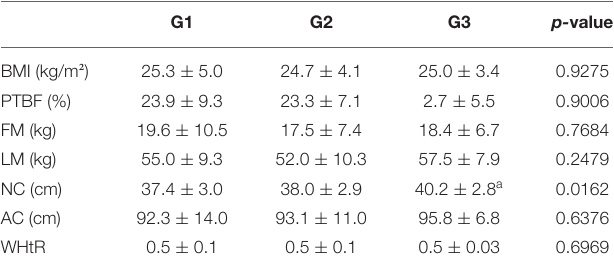
TABLE 4 | Body composition of men stratified by group of people living with HIV/AIDS with (G1) and without HALS (G2) and control group (G3).